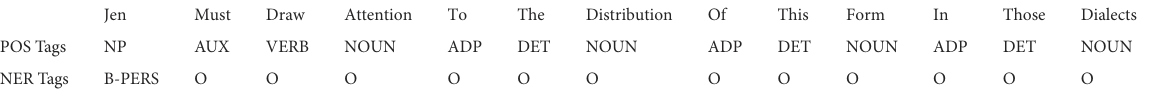
TABLE 1 An English example sentence with corresponding POS tags (line 2) and NER tags (line 3). Jen Must Draw Attention To The Distribution